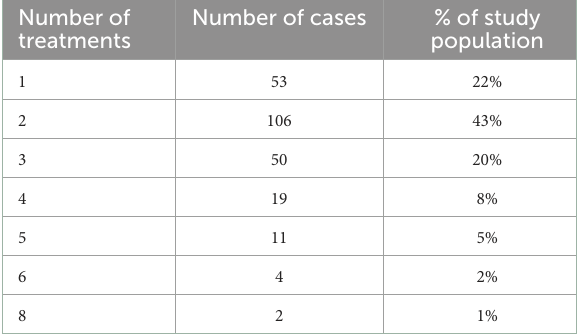
TABLE 4 The number of dogs receiving between 1 and 8 treatments and their percentage of the study population ( n = 245). Number of Number of cases % of study treatments